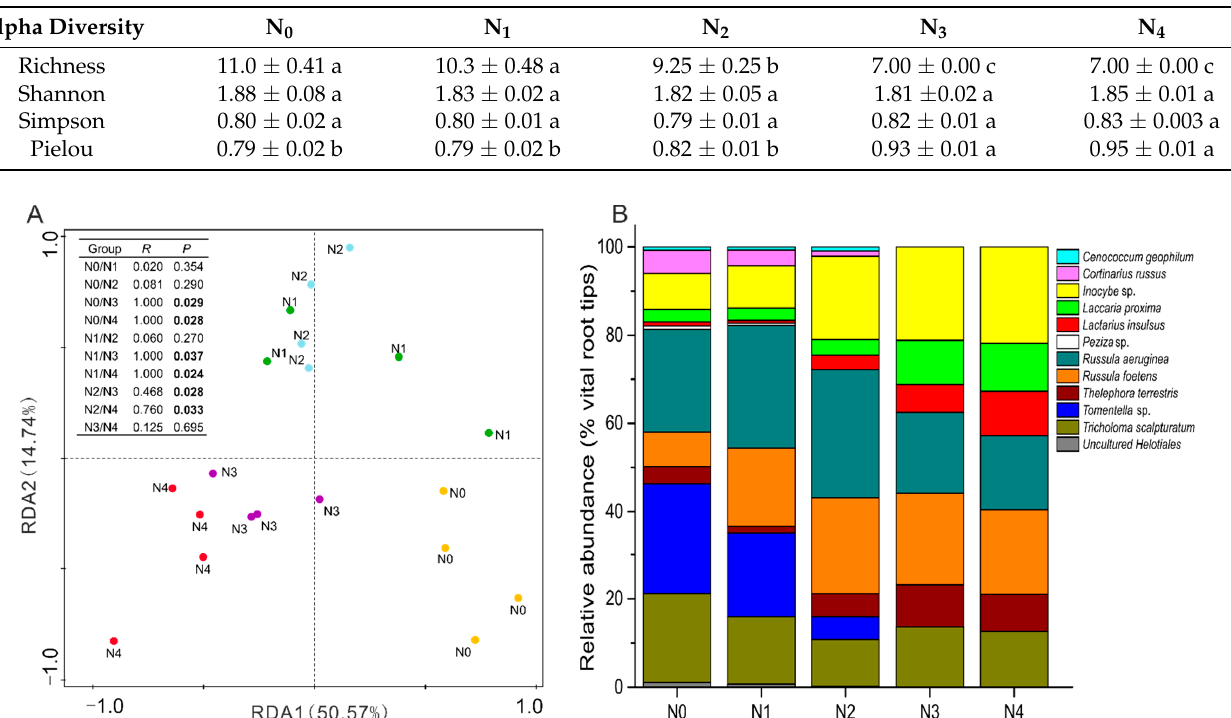
Figure 2. Redundancy analysis (RDA) of ectomycorrhizal species ( A ) and relative abundance of ectomycorrhizal fungi species forming communities ( B ) in the poplar plantation under five N addition treatments: N 0 : 0 kg N ha − 1 yr − 1 , N 1 : 50 kg N ha − 1 yr − 1 , N 2 : 100 kg N ha − 1 yr − 1 , N 3 : 150 kg N ha − 1 yr − 1 , N 4 : and 300 kg N ha − 1 yr − 1 . NO 3 − -M, NO 3 − in mineral soil; NH 4+ -M, NH 4+ in mineral soil; TC-M, TC in mineral soil; pH-M, pH in mineral soil; AP-M, AP in mineral soil; AP-H, AP in humus layer. TP-H, TP in humus layer; TP-FR, TP in fine roots. Bars indicate means ± SE ( n = 4). The ectomycorrhizal species composition was analyzed by ANOSIM using Bray-Curtis as the similarity measure. p -values and R -values after sequential Bonferroni correction are indicated. Significant p -values (<0.05) are indicated in bold